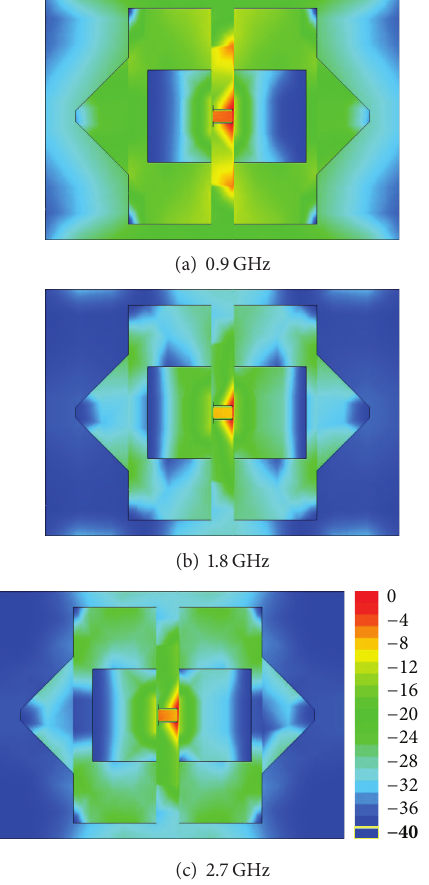
Figure 6: Current distributions on the electric